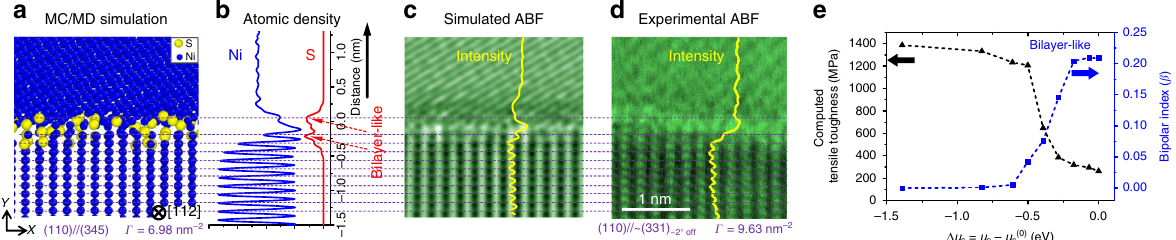
Fig. 4 Atomic structure of the Type B (bilayer-like) complexion. a Hybrid MC/MD simulated (110)//(345) GB. The corresponding ( b ) Ni and S density pro fi les. c Simulated ABF image using the atomic structure obtained by the hybrid MC/MD simulation. d Experimental ABF image of a (110)//~(331) ~2°off GB facet. See two additional examples of Type B complexions in Supplementary Figs. 33 and 34. e Computed tensile toughness and bipolar index β curves with increasing S chemical potential, suggesting a strong correlation between the formation bipolar interfacial structures and embrittlement. See additional analyses in Supplementary Fig. 9 and further discussion about the bipolar index β in Supplementary Notes 2 and 16, as well as discussion of embrittlement and computed tensile toughness in Supplementary Notes 17 and